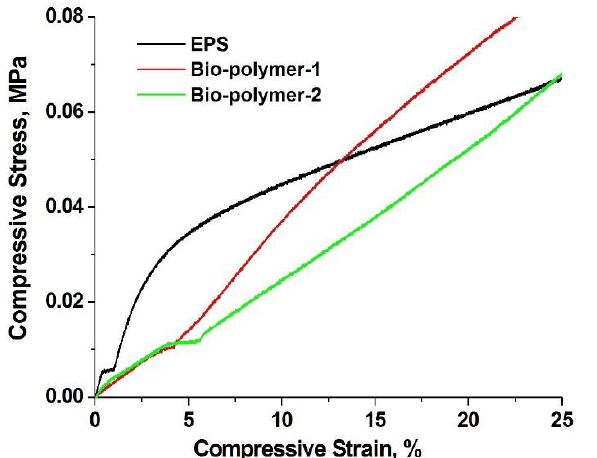
Figure 10. The stress-strain curves of bio-polymer composite in comparison with commercial EPS. Table 3. Compressive strength of bio-polymer composite in comparison with commercial